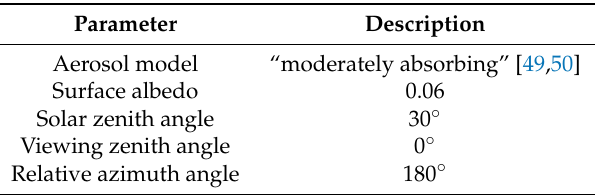
Table 4. The parameterization of aerosol model, geometry, and surface for generating synthetic TROPOMI O 2